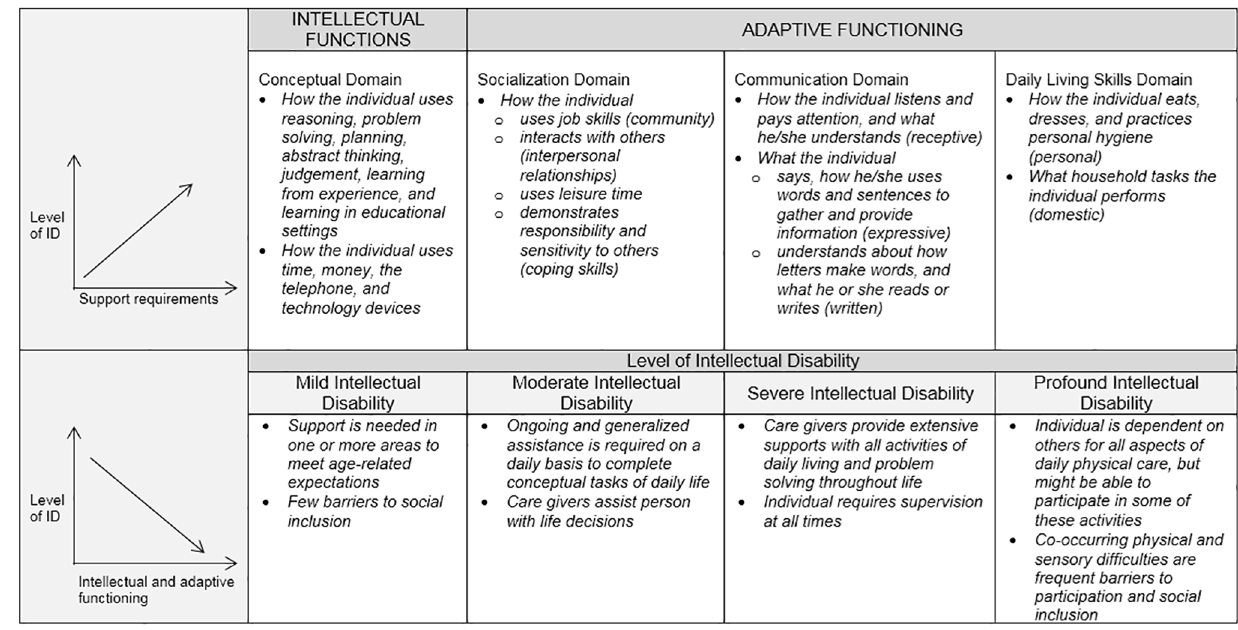
Figure 1. Continuum of support needs according to severity of ID a